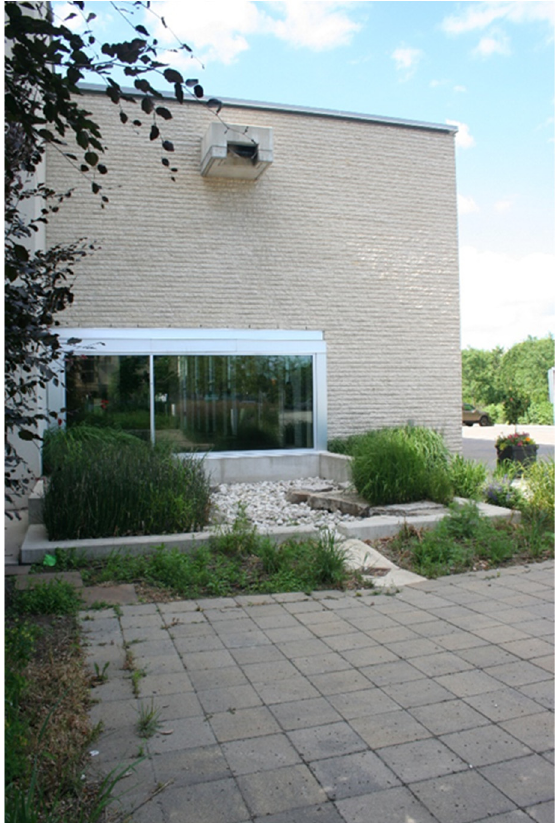
Figure 13. A view of the roof scupper and wetland (Credit: Roberto